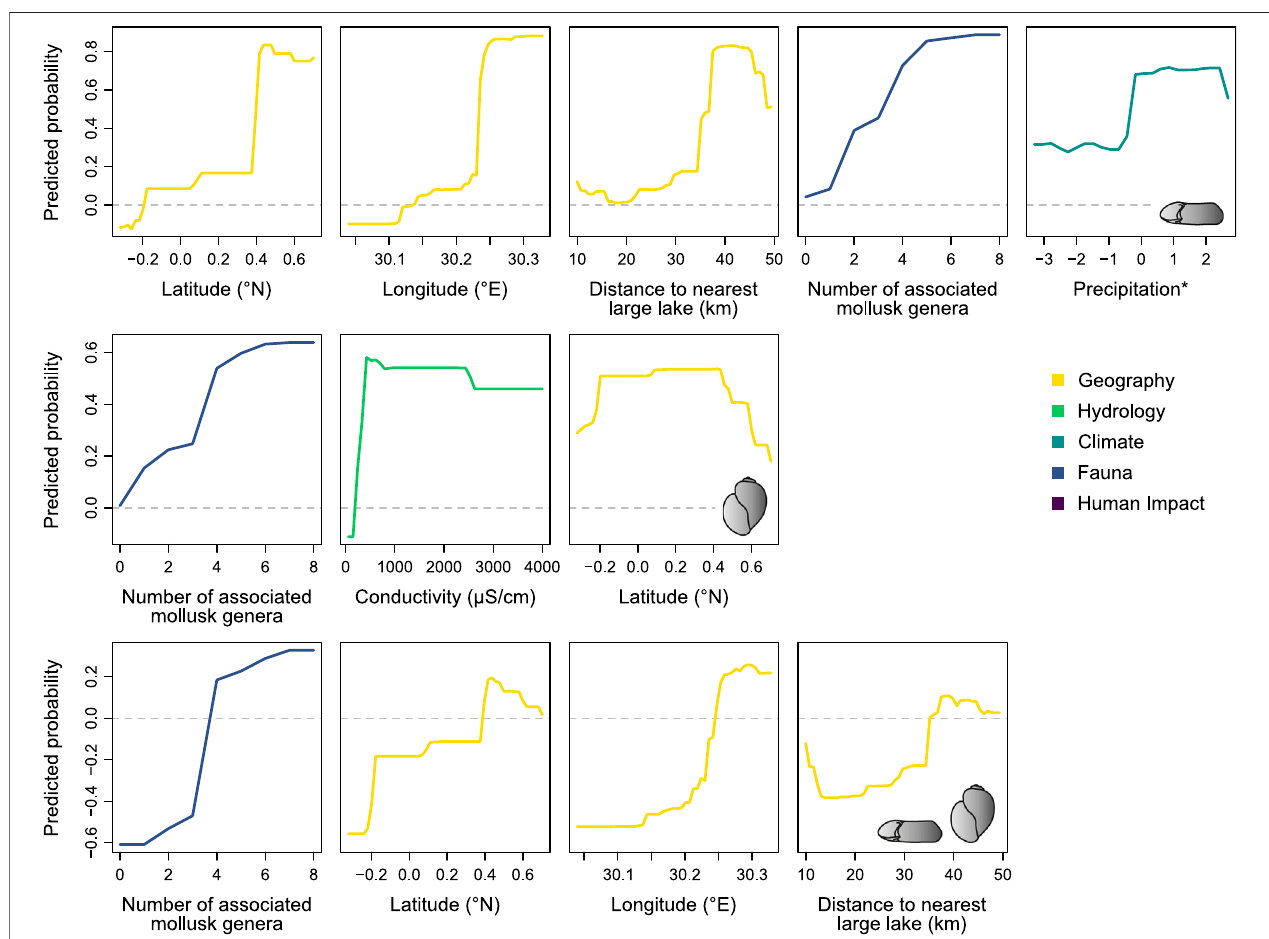
FIGURE3| Predicted probabilities for thepresence of Biomphalaria (upper panels), Bulinus (middlepanels) and both genera combined (lower panels) in relation to selected predictor variables from each dataset. Only the contributors that were found signi fi cant by both importance metrics (MDA and MDG) for the entire dataset are shown (compare Figure 2 ; see Supplementary Figures S3 – S8 for the remaining predictors as well as for the predicted probabilities for CLF 1). The asterisk denotes scaled parameters, i.e., the x -axis does not denote the original extent of the variable.